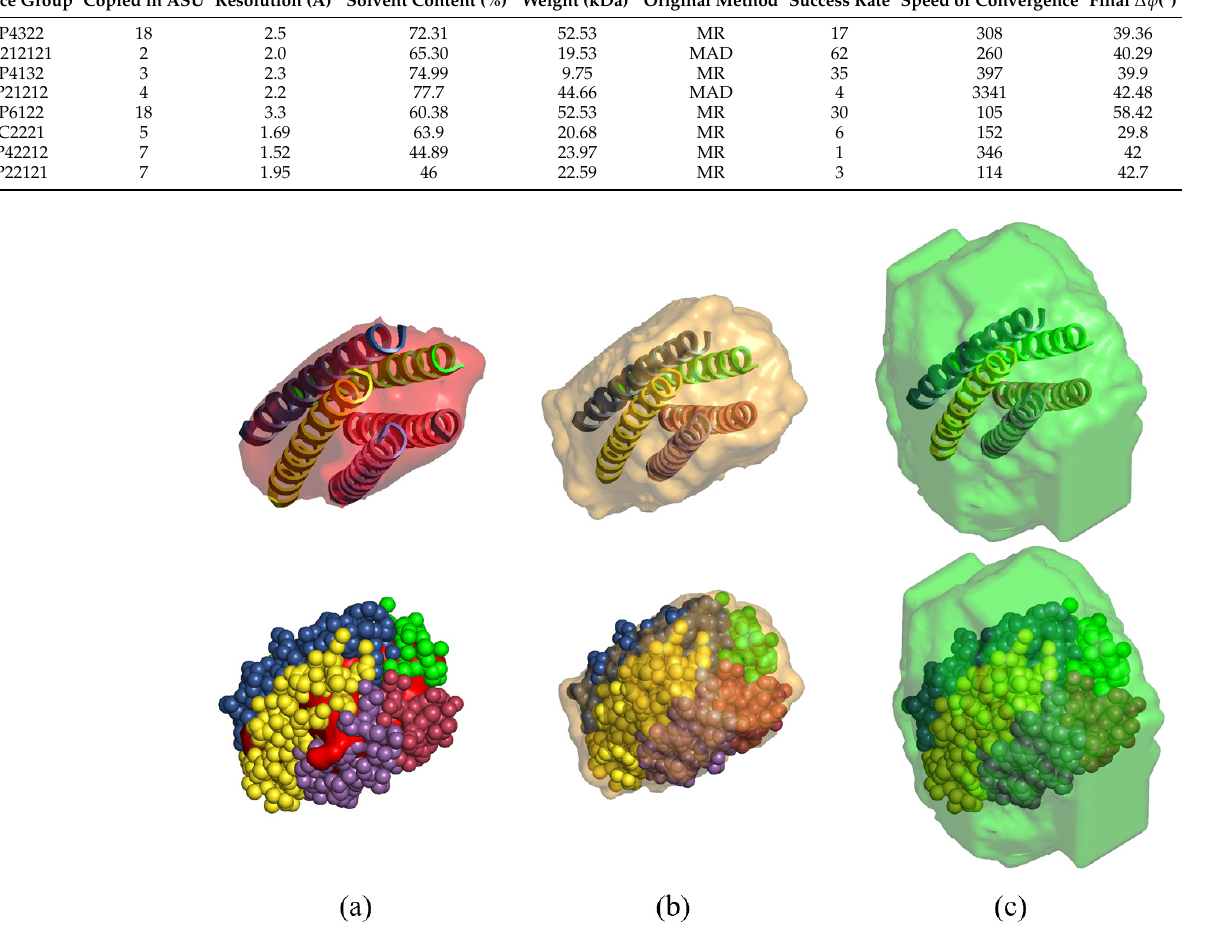
Figure 7. In order to apply NCS density averaging, an NCS mask covering the whole protein must be reconstructed from scratch. Figure above demonstrates a reconstructed ( a ) NCS core, ( b ) NCS mask, and ( c ) asymmetric unit of a successful run starting from random phases. The PDB posted structure is superimposed here as a